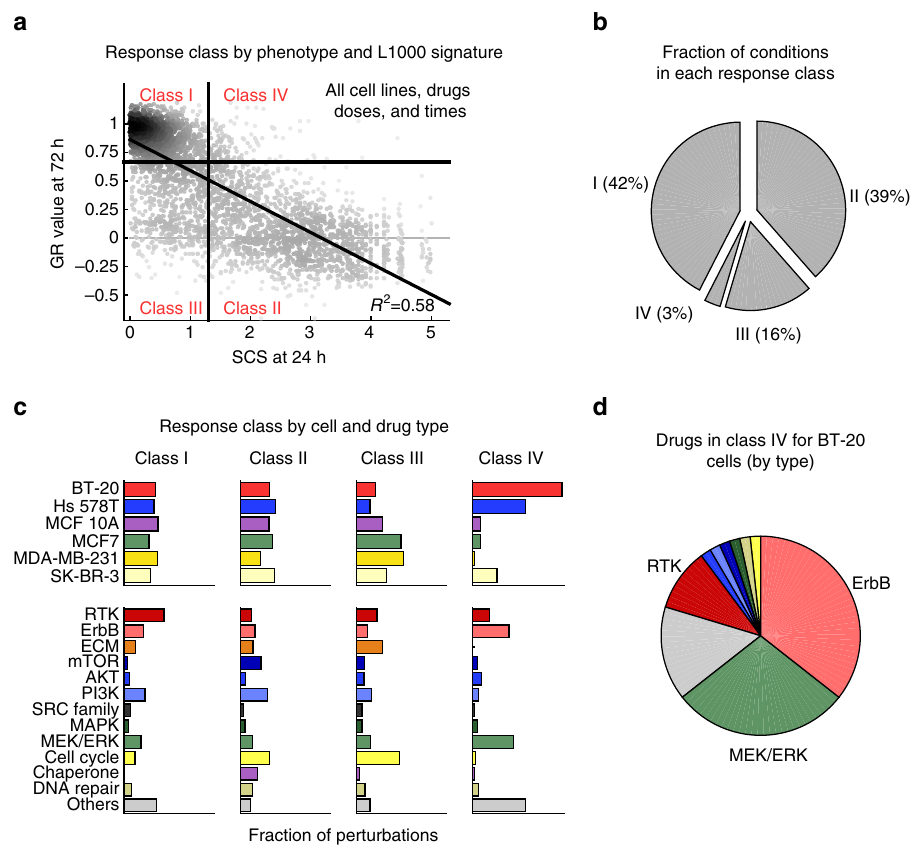
Fig. 4 Transcriptional responses are generally correlated with phenotypic responses. a Scatterplot showing the phenotypic response (GR) and consistency of L1000 responses at 24h (SCS) for all drugs and all cell lines divided into four classes based on a cutoff of GR = 0.66 and SCS = 1.3. Class I: Non- responsive by both measures; Class II: responsive by both measures; Class III: responsive by GR, but not by L1000 SCS; Class IV: responsive based on L1000 SCS, but not by GR. b Fraction of perturbations in Class I – IV responses broken down by cell lines (left) and drug target classes (right). c Fraction of perturbations in response classes I – IV. d Breakdown of Class IV perturbations in BT-20 by drug target